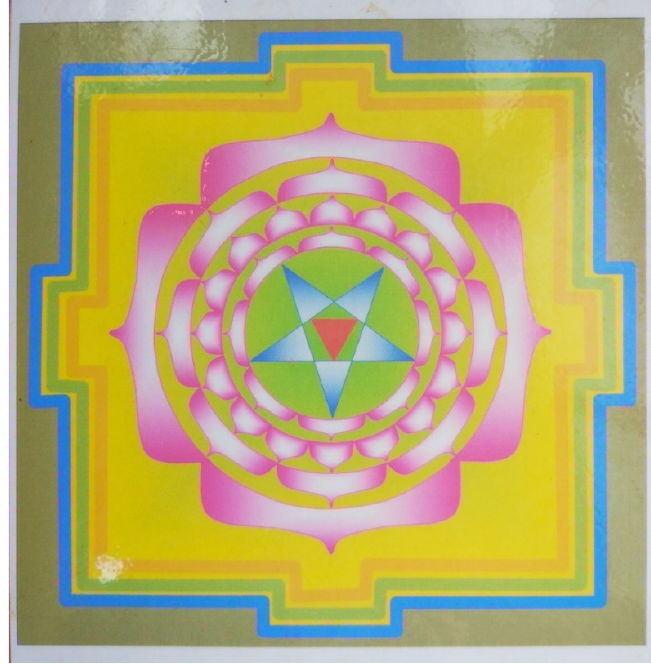
Figure 5. Ś y ā m ā yantra . Credit: based on material provided in Ś aktipur. Figure 5. ´Sy¯am¯a yantra . Credit: based on material provided in